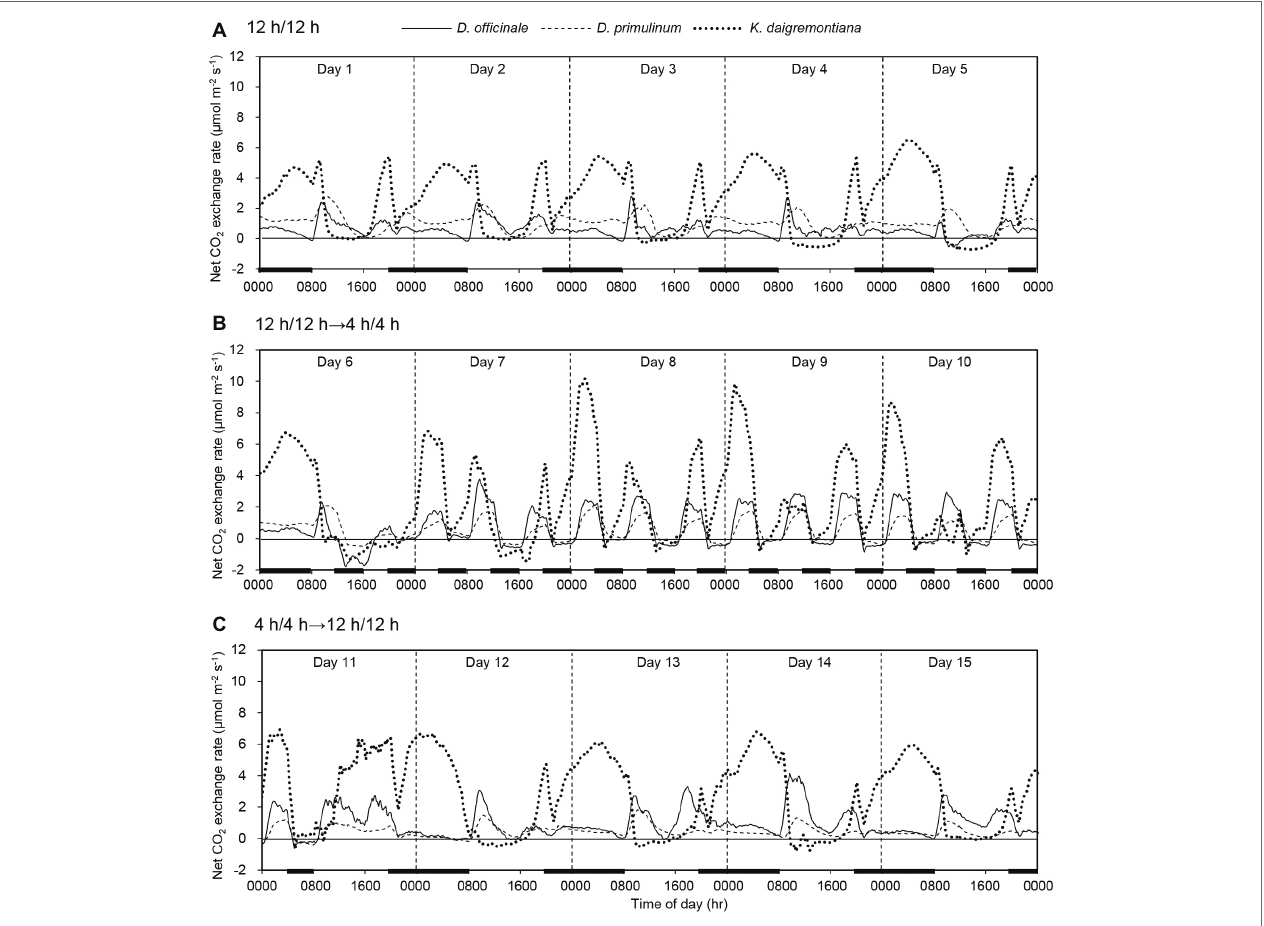
FIGURE 1 | Effect of light/dark cycle on net CO 2 exchange rates of D. officinale , D. primulinum , and K. daigremontiana . Light/dark cycle was 12/12 h from day 1 to day 5 (A) , 4/4 h from day 6 to day 10 (B) , and 12/12 h from day 11 to day 15 (C) . The thin black line on the horizontal axis indicates light period, and the thick black line indicates dark